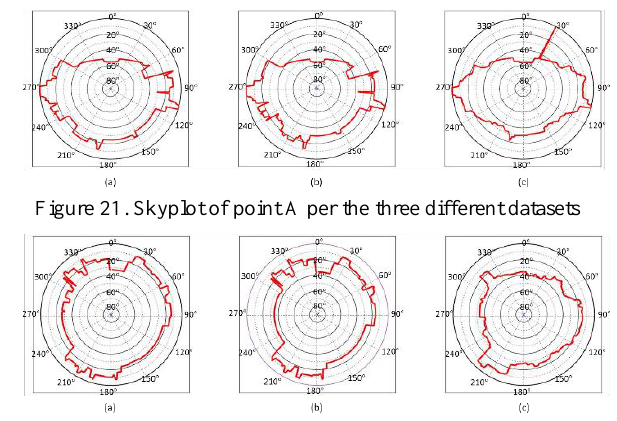
Figure 22. Skyplot of point B per the three different datasets Figure 21 and Figure 22 show point A and point B’s skyplots per (b) is the LiDAR data with superimposed columns, and (c) is